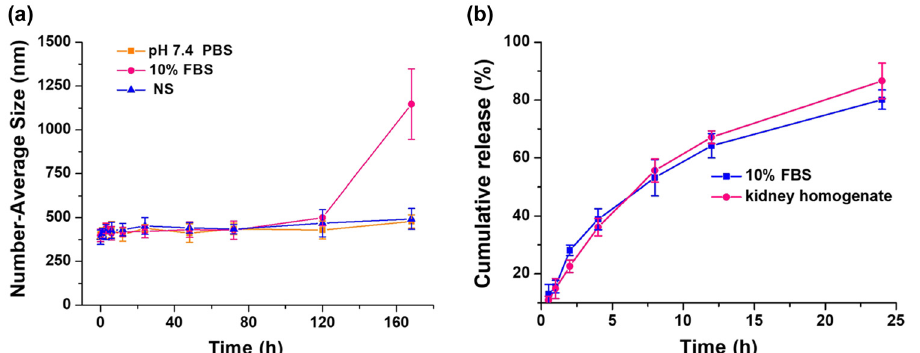
Figure 5: Stability and in vitro release assays of Em - MNPs in di ff erent media. The stability of Em - MNPs ( a ) measured by HD in PBS ( pH 7.4 ) , 10% FBS, and saline ( NS ) at 37°C. In vitro release assay of Em released from Em - MNPs ( b ) in 10% FBS and kidney homogenate at